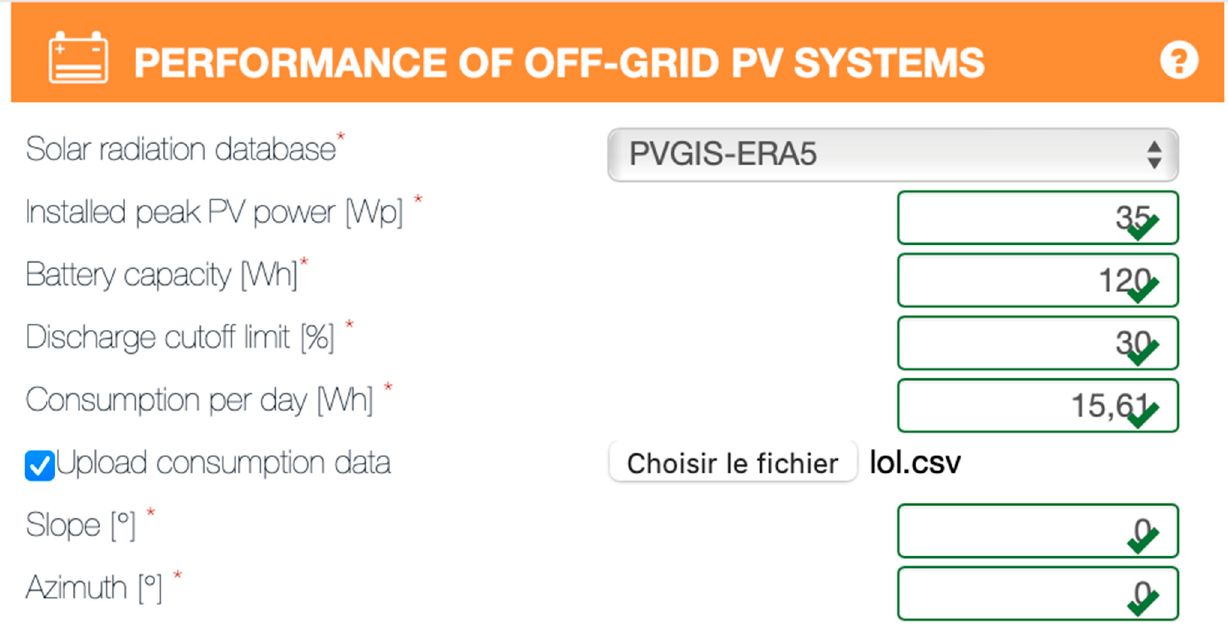
Figure 4. Screenshot of the parameters in the PVGIS online tool used to confirm theoretically the choice of our solar panel. The symbols * correspond to the required parameters to input.